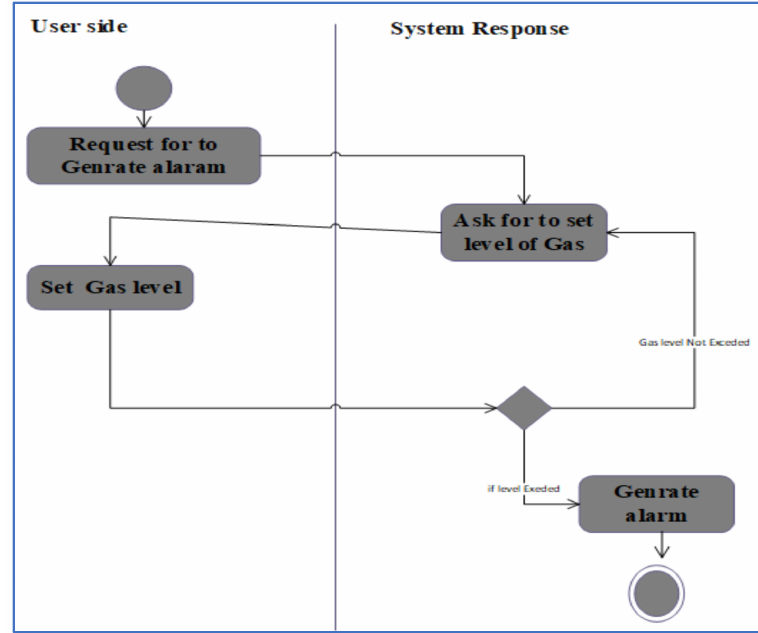
Figure 3. Gas leakage on/off